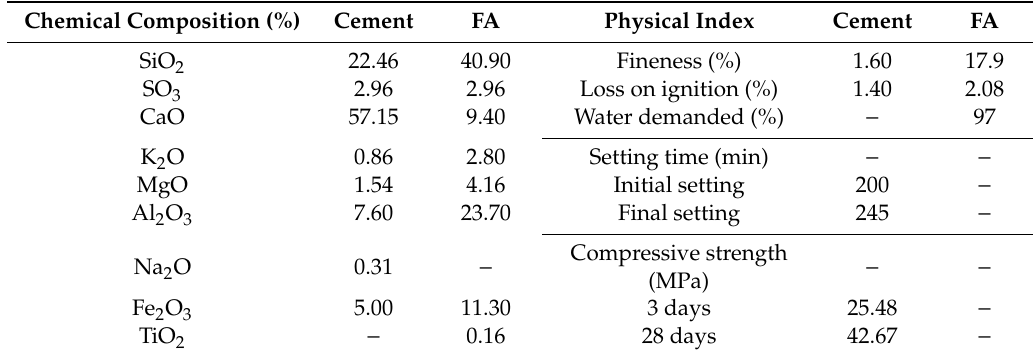
Table 1. The main performance indexes of cement and FA.